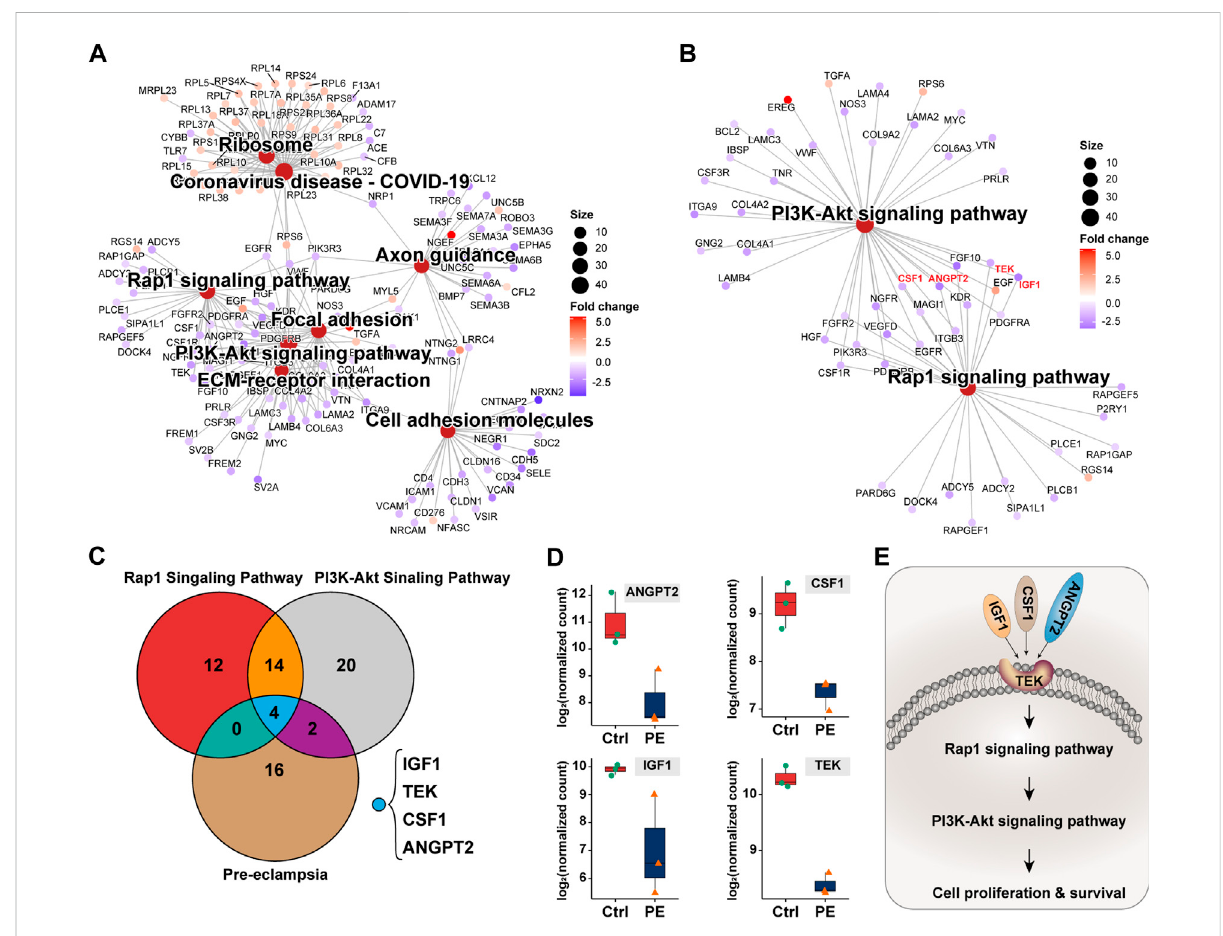
FIGURE 5 Deduction of the pathogenetic hypothesis of pre-eclampsia. (A) Topological network of KEGG signaling pathways of interest. (B) Topological network of the PI3K-Akt signaling pathway and Rap1 signaling pathway showing the overlapped differentially expressed genes. (C) Venn diagram showing the distribution of the differentially expressed genes between PI3K-Akt signaling pathway, Rap1 signaling pathway, and pre-eclampsia. (D) Box plot showing the expression and comparison of IGF1, ANGPT2, TEK, and CSF1 between groups of the control and pre-eclampsia. (E) Schematic illustration of IGF1/ANGPT2/TEK/CSF1-mediated